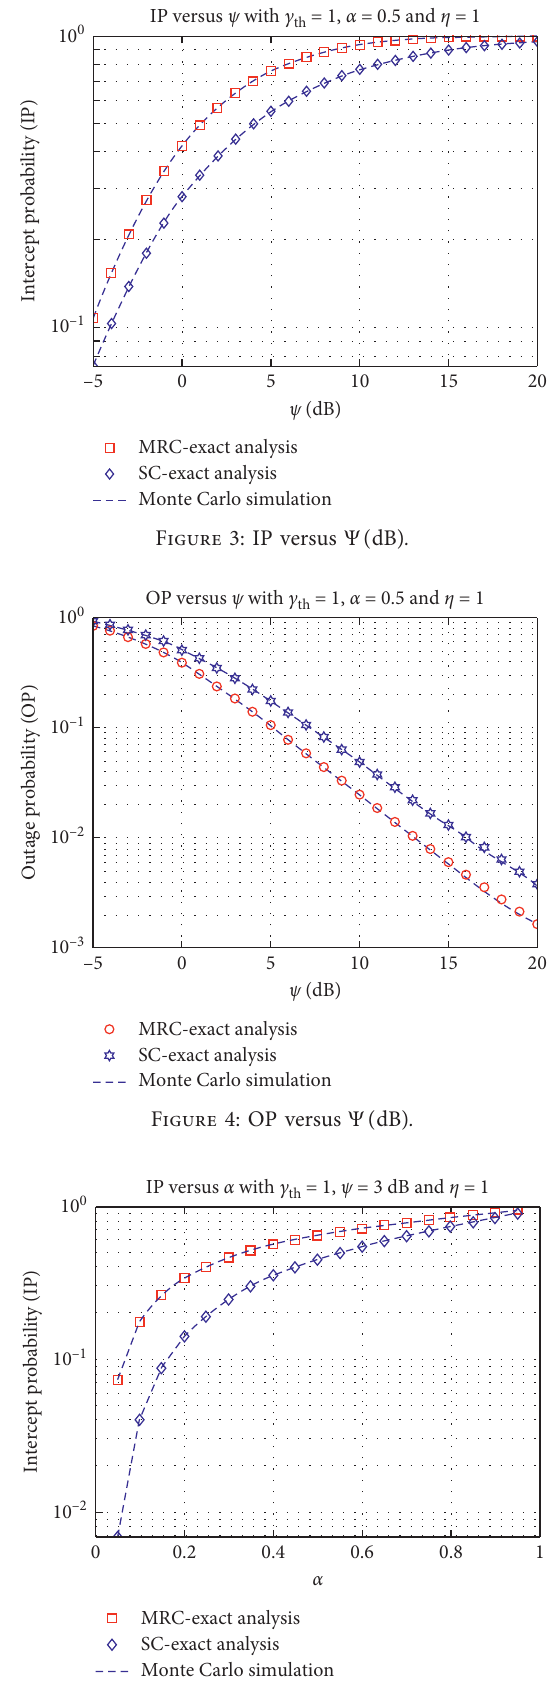
Figure 5: IP versus α